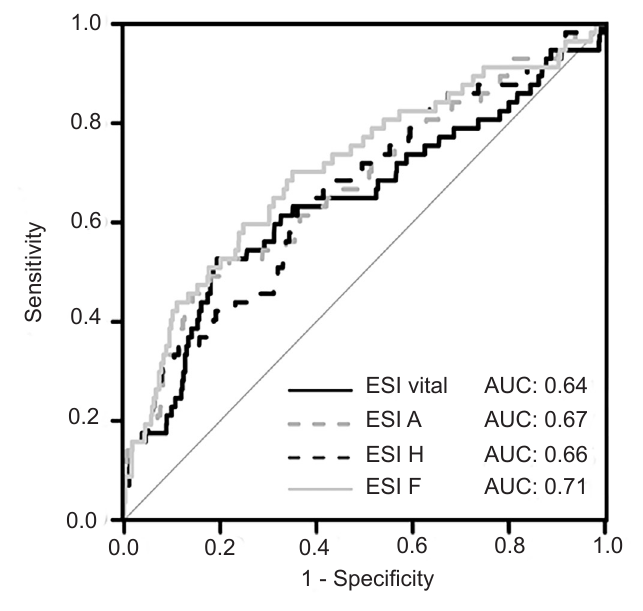
Figure 2. Comparison of area under the receiver operating characteristic (ROC) curve of the different modifications of the emergency severity index (ESI) vital, ESI A, ESI H, and ESI F. The black continuous line shows the ESI vital including pulse, respiratory rate, and oxygen-saturation. The grey dotted line shows the ESI A including ESI vital and activity of daily living deterioration. The black dotted line shows ESI H including ESI vital and accuracy of medical history. The grey continuous line shows ESI F including ESI vital and the first impression by the physician.